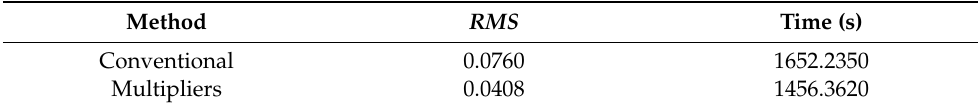
Table 3. RMS data fitting error and time of inversion for the field